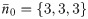
Stochastic modeling of B. subtilis competence.(A) The deterministic model of each circuit (see Eqs 6 and 7) exhibits three dynamic regimes (excitable, oscillatory, and mono-stable), depending on the ComK induction rate αk, which models stress level. (B) The stochastic model (see Eqs 1–5) reveals the ensuing distribution of ComK levels in each of the three dynamic regimes (excitable, oscillatory, and mono-stable). The fraction of the distribution in the responsive state f (determined by the inflection points, see Materials and Methods) is shaded. (C) Whereas the deterministic model exhibits sharp transitions between the dynamic regimes (dashed lines), the stochastic model exhibits a continuous dependence of f on induction rate. We see that for both circuits, stochasticity extends the viable response range (0 < f < 1) beyond the transitions predicted by the deterministic model, in both directions, by the factors given above the arrows (see Materials and Methods). Parameters are as in [16] and are given in S1 Text. In A and B, from left to right, the values of the control parameter are αk = {0.072, 1.15, 36}/hour (native) and αk = {0.036, 1.8, 36}/hour (SynEx). In A, from left to right, the initial conditions are n¯0={3,3,3} ComK molecules and m¯0={15,5,0.1} ComS molecules (native), and n¯0={0.8,2,1} ComK molecules and m¯0={0.05,35,50} MecA molecules (SynEx); in the excitable regime (left), the initial conditions are chosen to demonstrate the single, transient excitation.